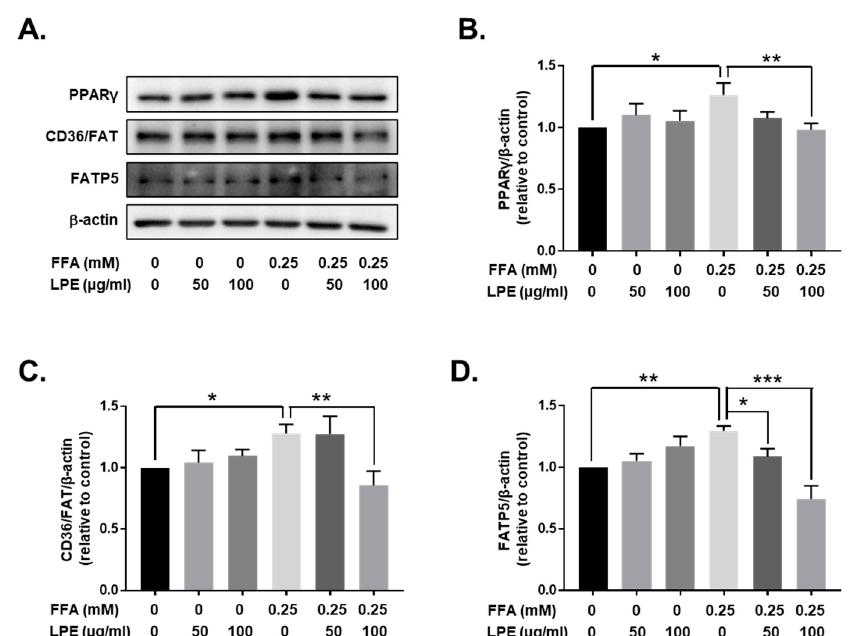
Figure 7. LPE treatment decreased the expression of proteins involved in fatty acid uptake in FFA- treated HepG2 cells. PPAR γ , CD36/FAT, and FATP5 protein expressions were analyzed by Western blotting. Beta-actin was used as the loading control for equal amounts of protein. ( A ) Representative immunoblots of PPAR γ , CD36/FAT, and FATP5, together with the relative intensity levels of ( B ) PPAR γ , ( C ) CD36/FAT, and ( D ) FATP5, were normalized to beta-actin. Data are shown as mean ± SEM, n = 5/group, * p < 0.05, ** p < 0.01, *** p < 0.001. One-way ANOVA was performed along with Fisher’s protected least significant difference test.